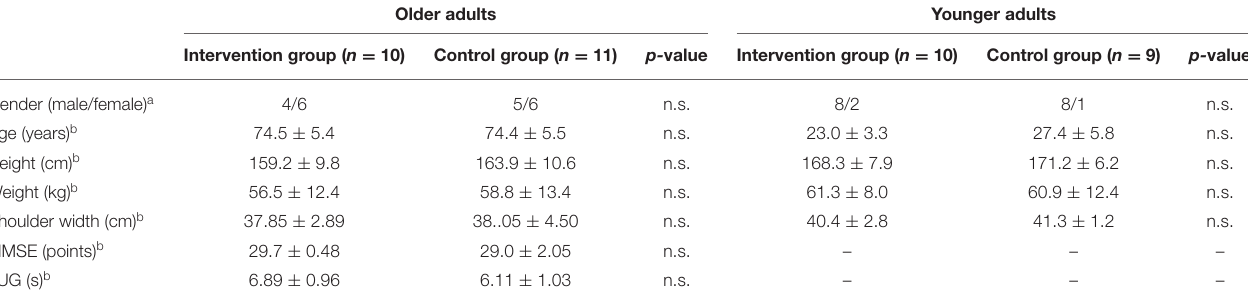
TABLE 1 | Participants’